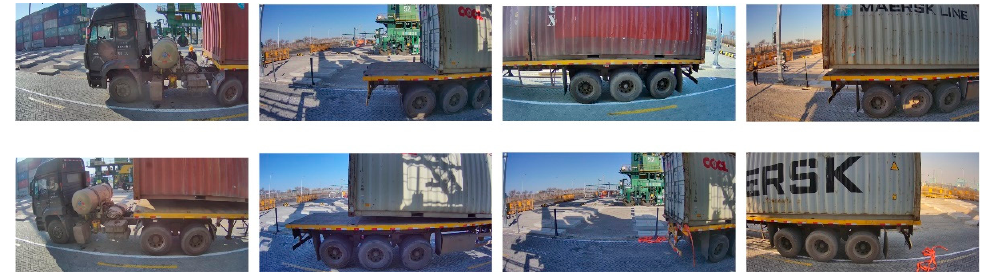
Figure 14. Camera installation drawing.